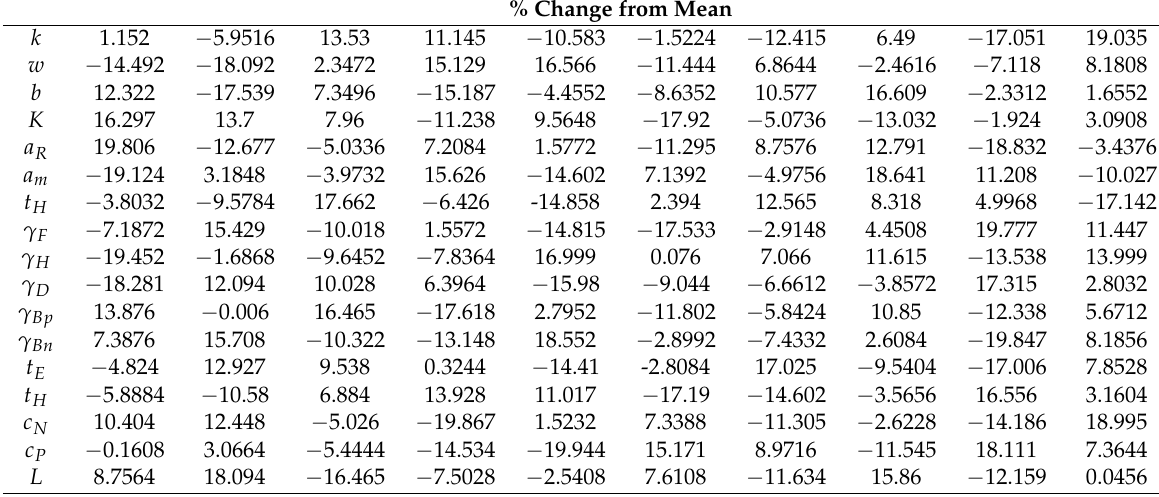
Table 2. Parameters used in 10 simulations for sensitivity analysis. Each column represents one simulation. Mean values provided in Table